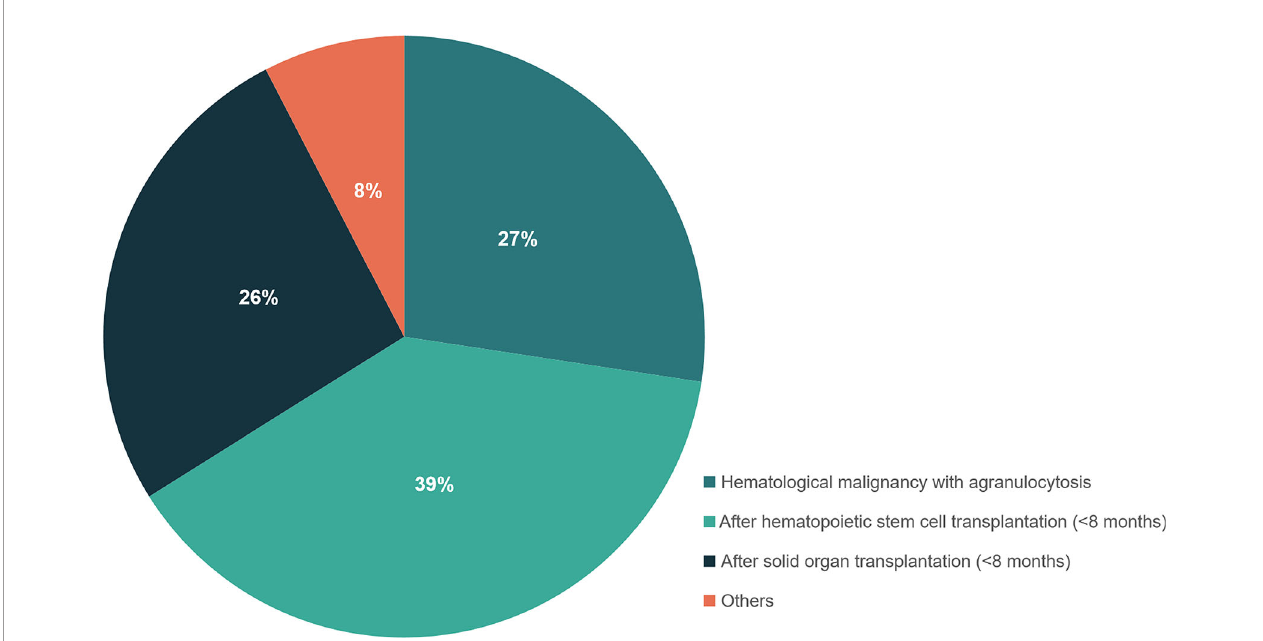
FIGURE 4 | The distribution of different types of underlying diseases in patients with positive mNGS but negative conventional test results. Patients who had hematological malignancies with agranulocytosis, or within 8 months after hematopoietic stem cell transplantation and within 8 months after solid organ transplantation were recommended to perform mNGS detection for suspected